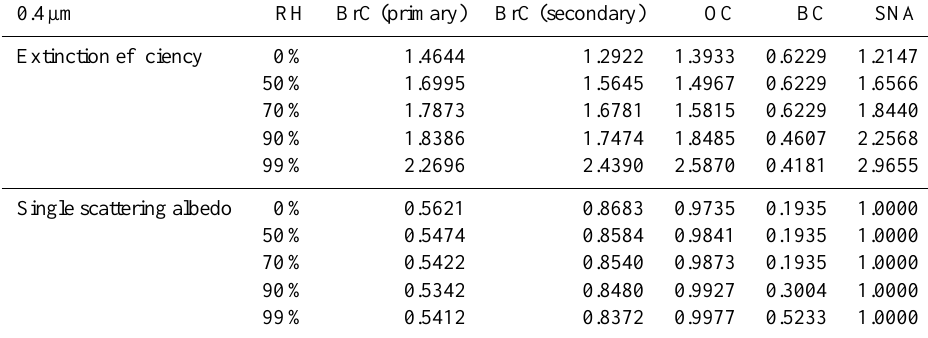
Table 4. Extinction efficiencies and SSAs of selected aerosols at 0.4µm used for calculating photolysis rates in GEOS-Chem. SNA indicates inorganic salt comprised of sulfate, nitrate and ammonium